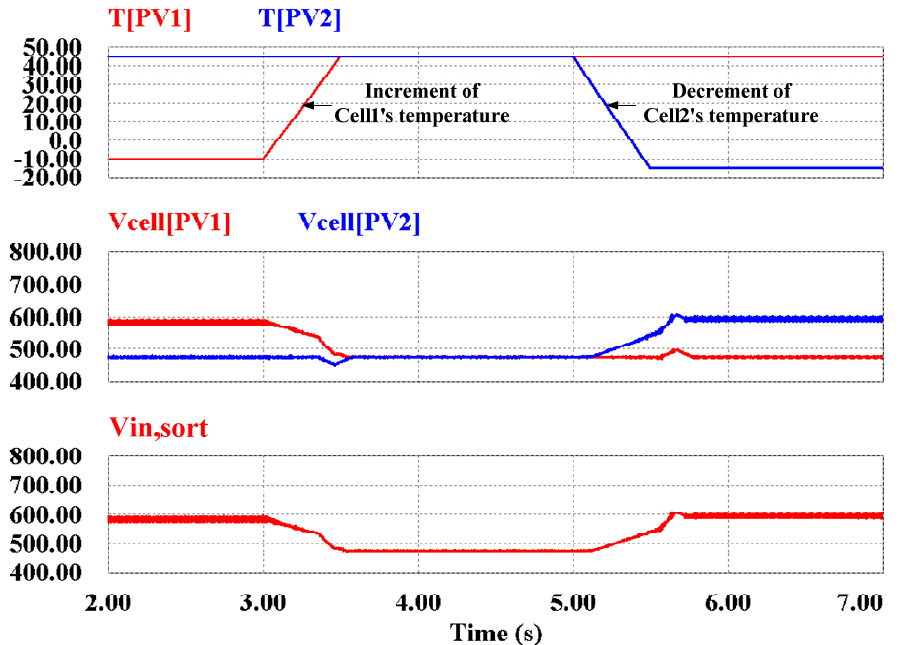
Figure 14. Simulation results for the temperatures of the PVs, two PV cells voltages, and sort ) when the temperatures of the PV cells are the sorted voltage ( V in ,